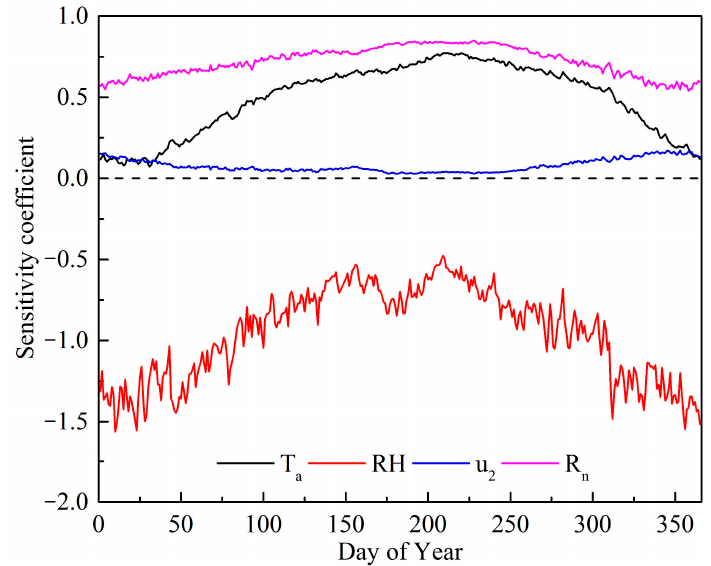
Figure 5. Changes of daily sensitivity coefficients of meteorological factors to ET 0 for the whole period.